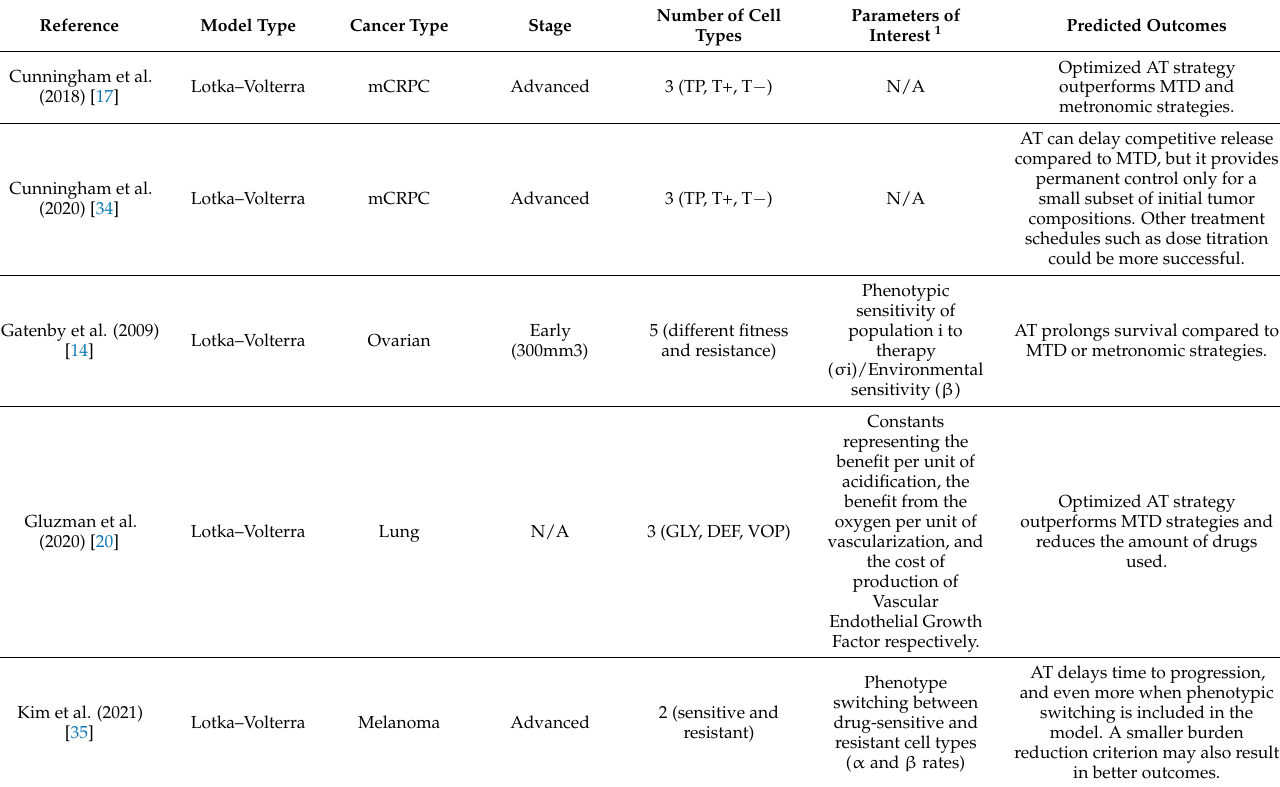
Table 1. Summary of the main studies modeling adaptive therapy strategies. AT = Adaptive therapy. mCRPC = metastatic castrate-resistant prostate cancer. 1 Parameters of interest that are specific to the considered article, and that are not classical. What we consider as classical parameters are parameters representing tumor size, subpopulations sizes and growth rates, competition coefficients, carrying capacities and treatment sensitivity, or their equivalent, which are common to most of the